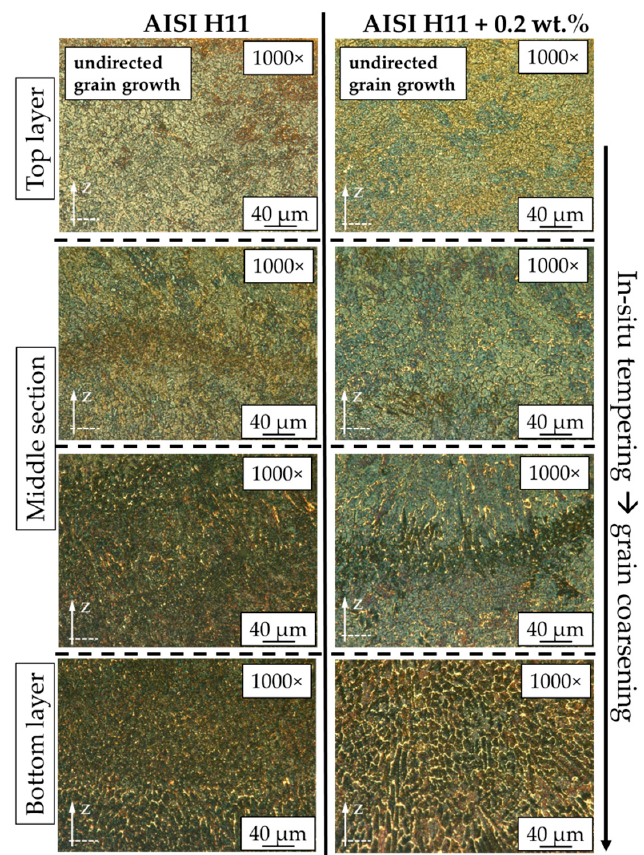
Figure A4. Microscope images of the local microstructure (top layer, middle section and bottom layer) of ten-layered sample made out of pure AISI H11 ( left ) and a powder mixture containing 0.2 wt. % carbon black nanoparticles ( right ) (etching method Behara I; process parameters: P = 600 W, (cid:1865)(cid:4662) = 2.7 g/min , f rate = 400 mm/min).